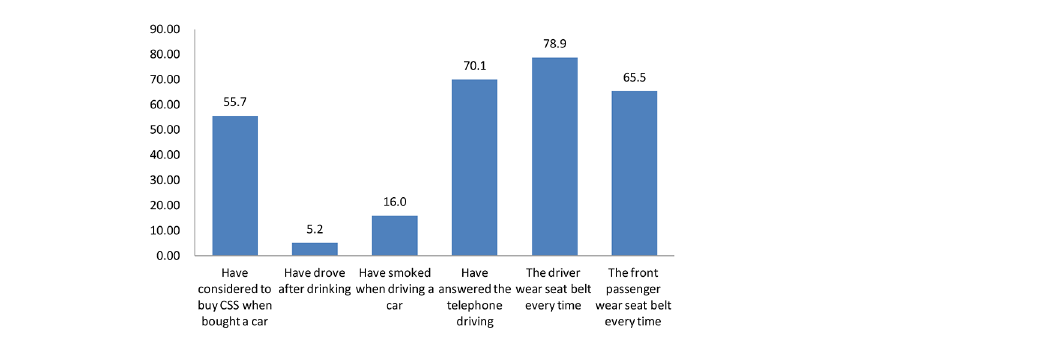
Fig 2. Parents' Behaviors on Driving Safety Percent (%).